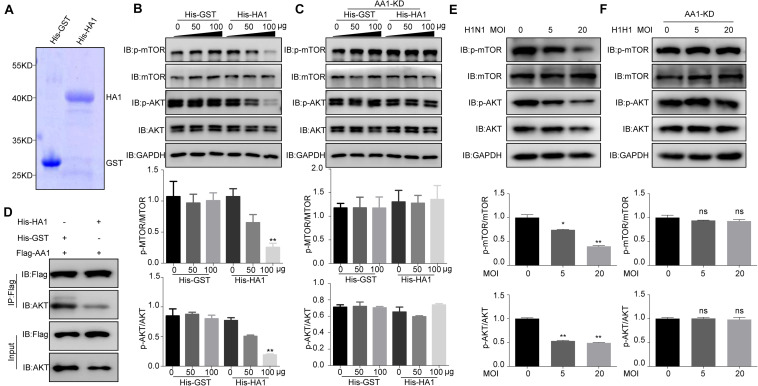
IAV HA1 is critical for dephosphorylation of AKT/mTOR. (A) Purified His-tagged HA1 was separated using SDS-PAGE and stained with Coomassie brilliant blue. (B) A549 cells and (C) HSP90AA1-knockdown (AA1-KD) A549 cells were serum-starved for 12 h and then incubated in DMEM containing His-GST or His-HA1 protein as indicated for 2 h. Cell lysates were analyzed by immunoblotting with anti-p-mTOR, anti-p-AKT, anti-mTOR, anti-AKT, and anti-glyceraldehyde 3-phosphate dehydrogenase antibodies. Ratio of p-mTOR to mTOR or p-AKT to AKT was normalized to control conditions. (D) HEK293T cells were transfected with Flag-HSP90AA1 (Flag-AA1). After transfection for 36 h, cells were treated with His-GST or His-HA1 (100 μg) for 12 h. Then, Flag-tagged sample was immunoprecipitated and immunoblotted with the indicated antibodies. (E) A549 cells or (F) HSP90AA1-knockdown (AA1-KD) A549 cells were incubated with H1N1 influenza A virus (MOI = 5.0 or 20.0) at 4°C for 2 h. Cell lysates were analyzed by immunoblotting with the indicated antibodies. Ratio of p-mTOR to mTOR or p-AKT to AKT was analyzed as (B,C). Error bars: mean ± SD of three independent tests. Two-way ANOVA; *P < 0.05; **P < 0.01 compared with control.